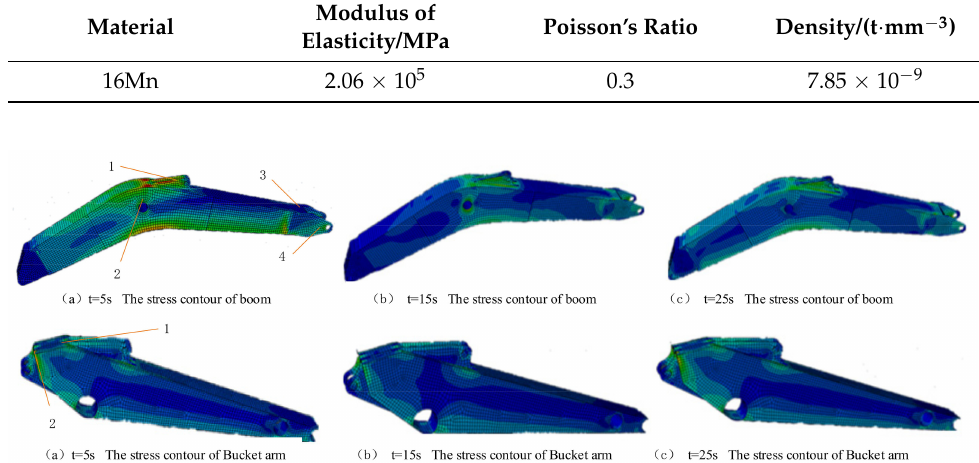
Figure 13. Stress contours of the boom and the arm at various